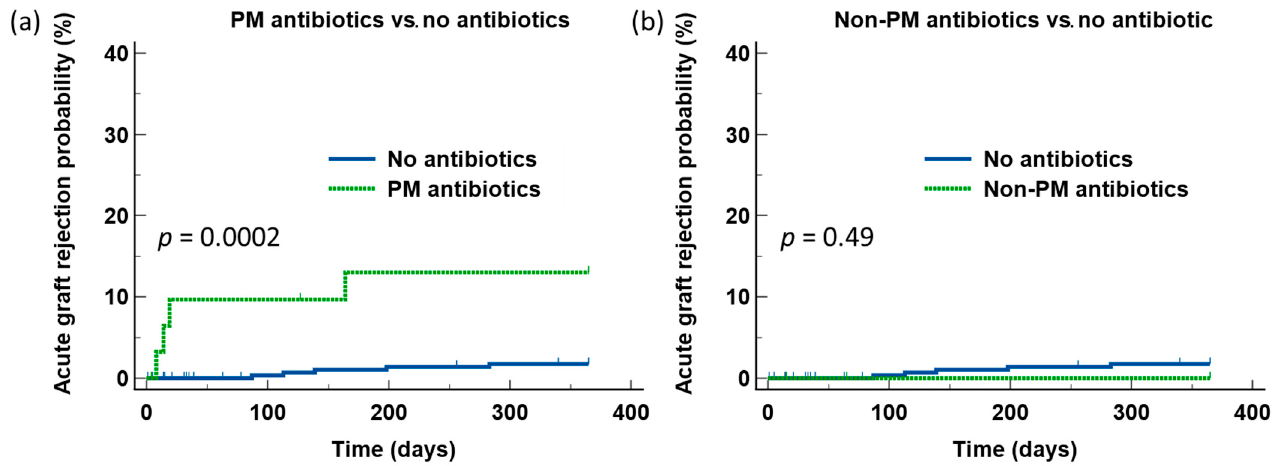
Figure 3. Comparison of the risks for acute graft rejection between patients who received PM and those who received non-PM antibiotics, with patients who did not receive any antibiotics in addition to the one dose of cefazolin in the operating room and PJP prophylaxis. Compared to those who did not receive any additional antibiotics, patients who received piperacillin/tazobactam or meropenem (PM) were at significantly higher risks for acute graft rejection during the first year after transplant ( a ). In contrast, such risks were not observed in patients who received non-PM antibiotics ( b ). Table 3. Characteristics of patients with PM exposure vs. no PM exposure.